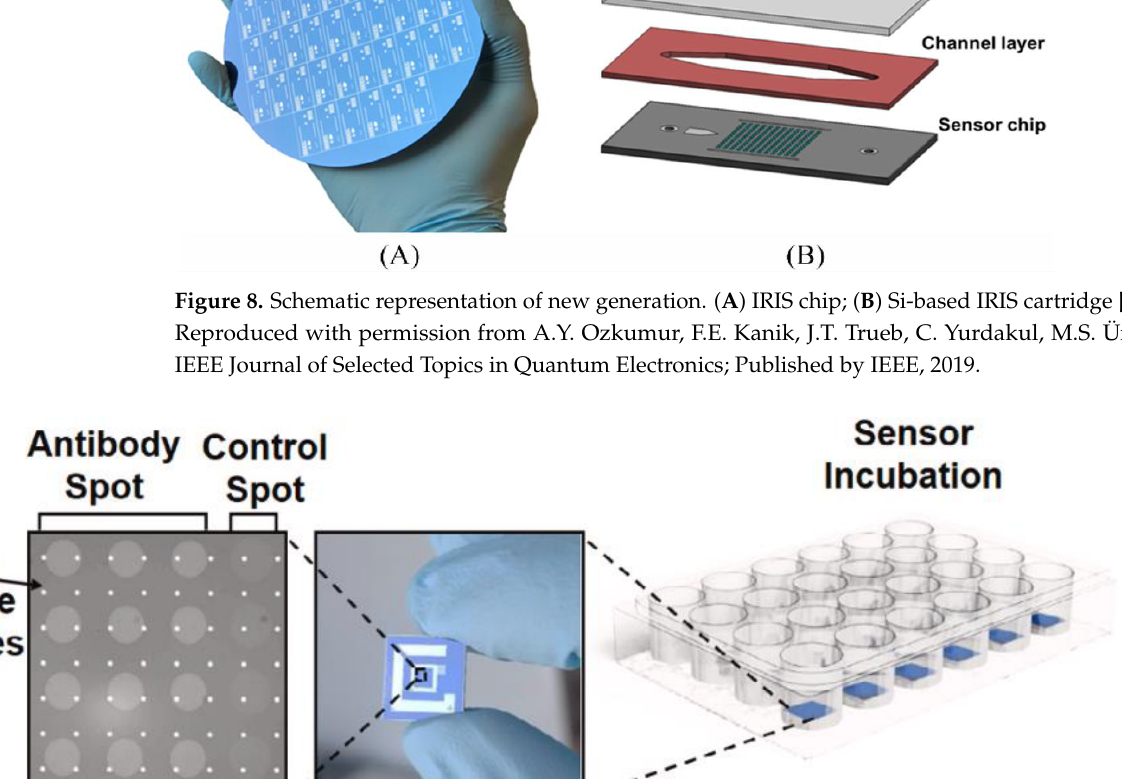
Figure 9. Schematization of IRIS chip surface decorated in an antibody array format with anti- E.coli and bovine serum albumin as a control. Experiment stage: incubation of spotted IRIS chips with 1 mL of serial E. coli concentrations in the 24-well plate [33]. Reproduced with permission from N. Zaraee, A.M. Bhuiya, E.S. Gong, M.T. Geib, N.L. Ünlü, A.Y. Ozkumur, J.R. Dupuis, M.S. Ünlü, Biosensors and Bioelectronics; Published by Elsevier, 2020.